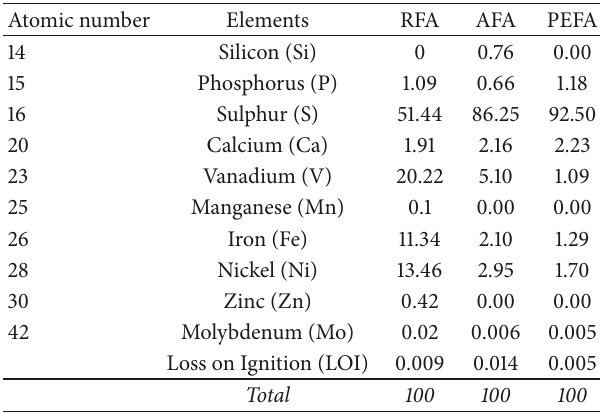
Table 1: Elemental composition of RFA, AFA, and PEFA as revealed by